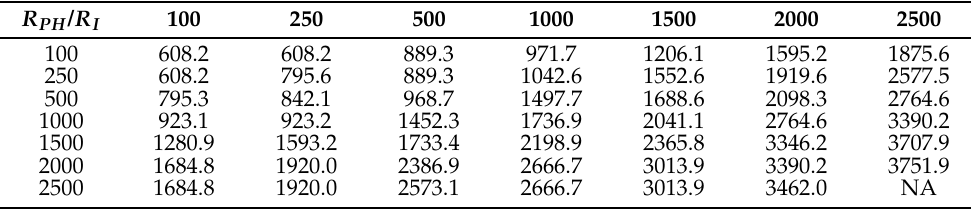
Table 6. Maximum HP[kW]